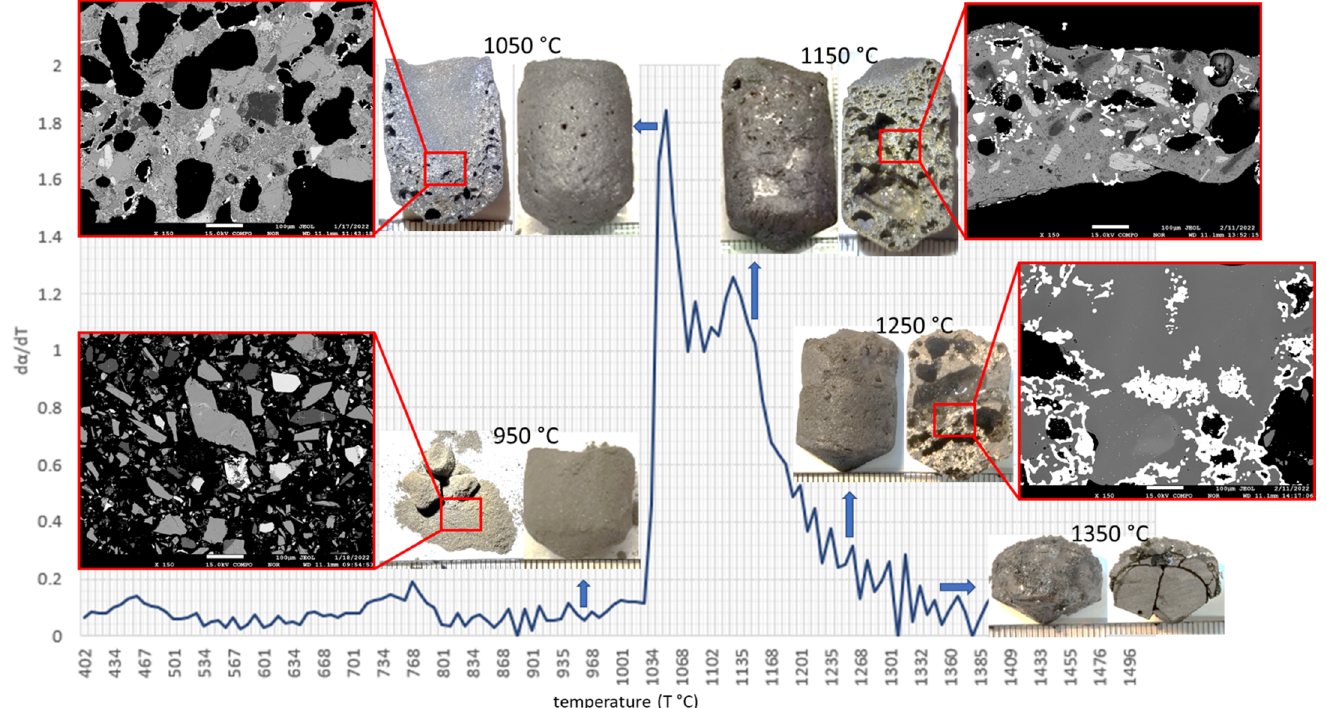
Figure 10. Photographs of samples at different temperatures (950, 1050, 1150, 1250, and 1350 °C), plotted on the derivative conversion curve of the baseline experiment with 95% Ar + 5% H 2 . The back-scattered electron images of the samples visualize the progression of mineral decompositions, slag, and metallic iron formation.